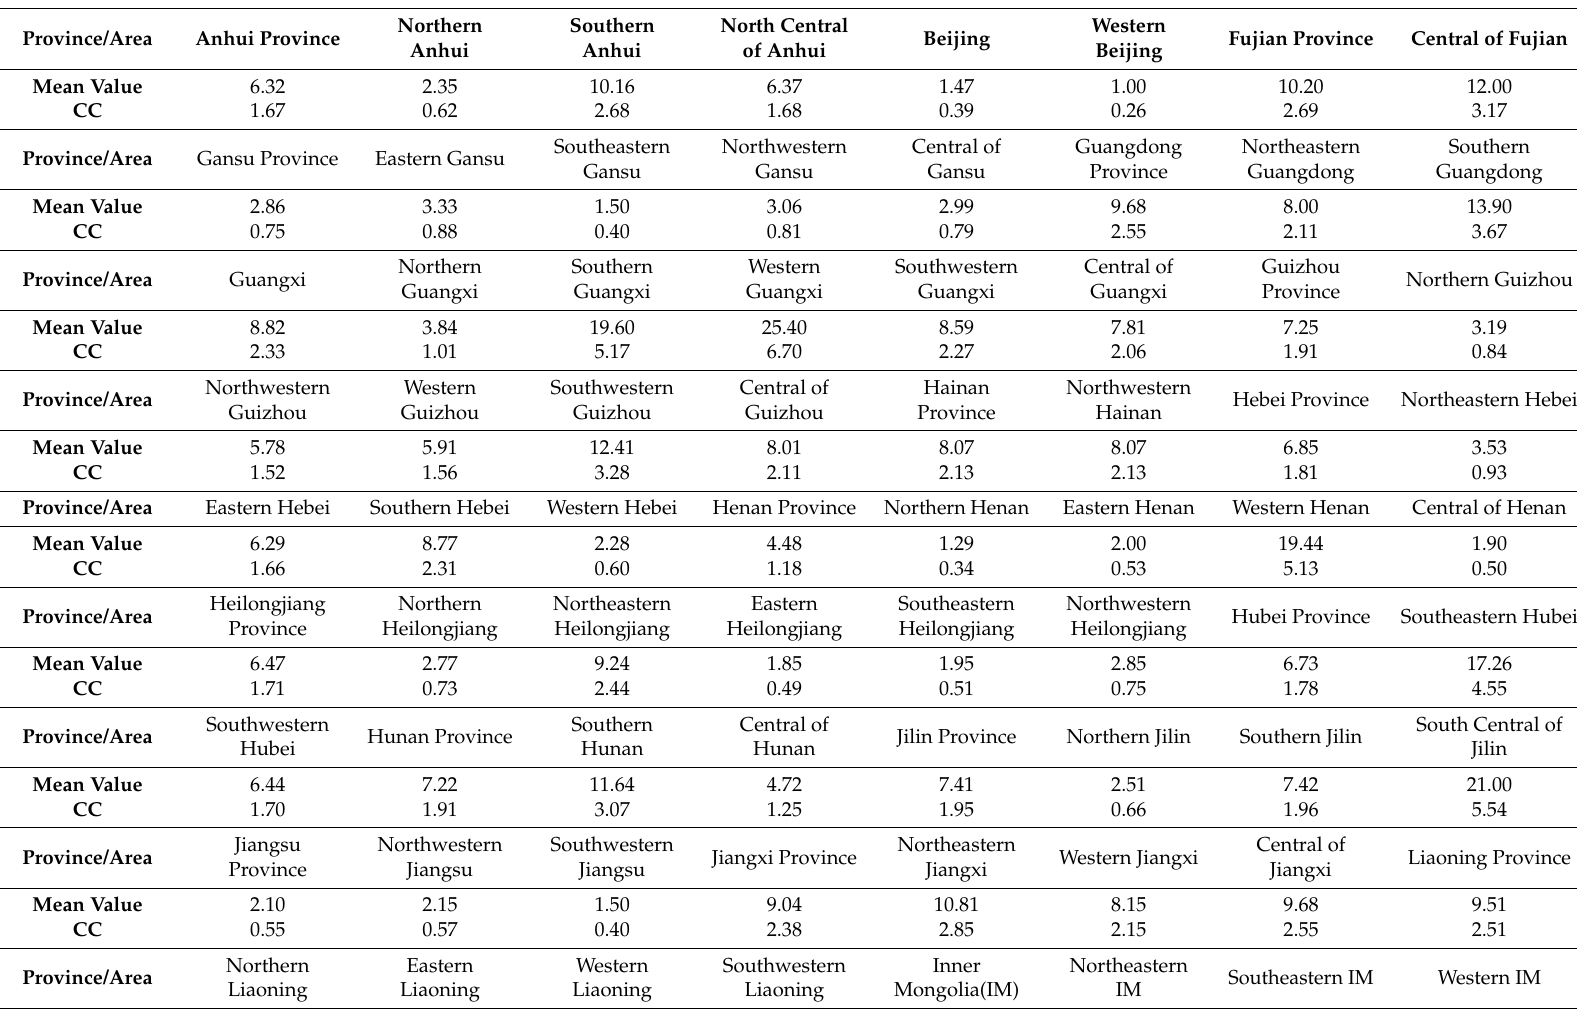
Table 4. Spatial variation of arsenic in Chinese